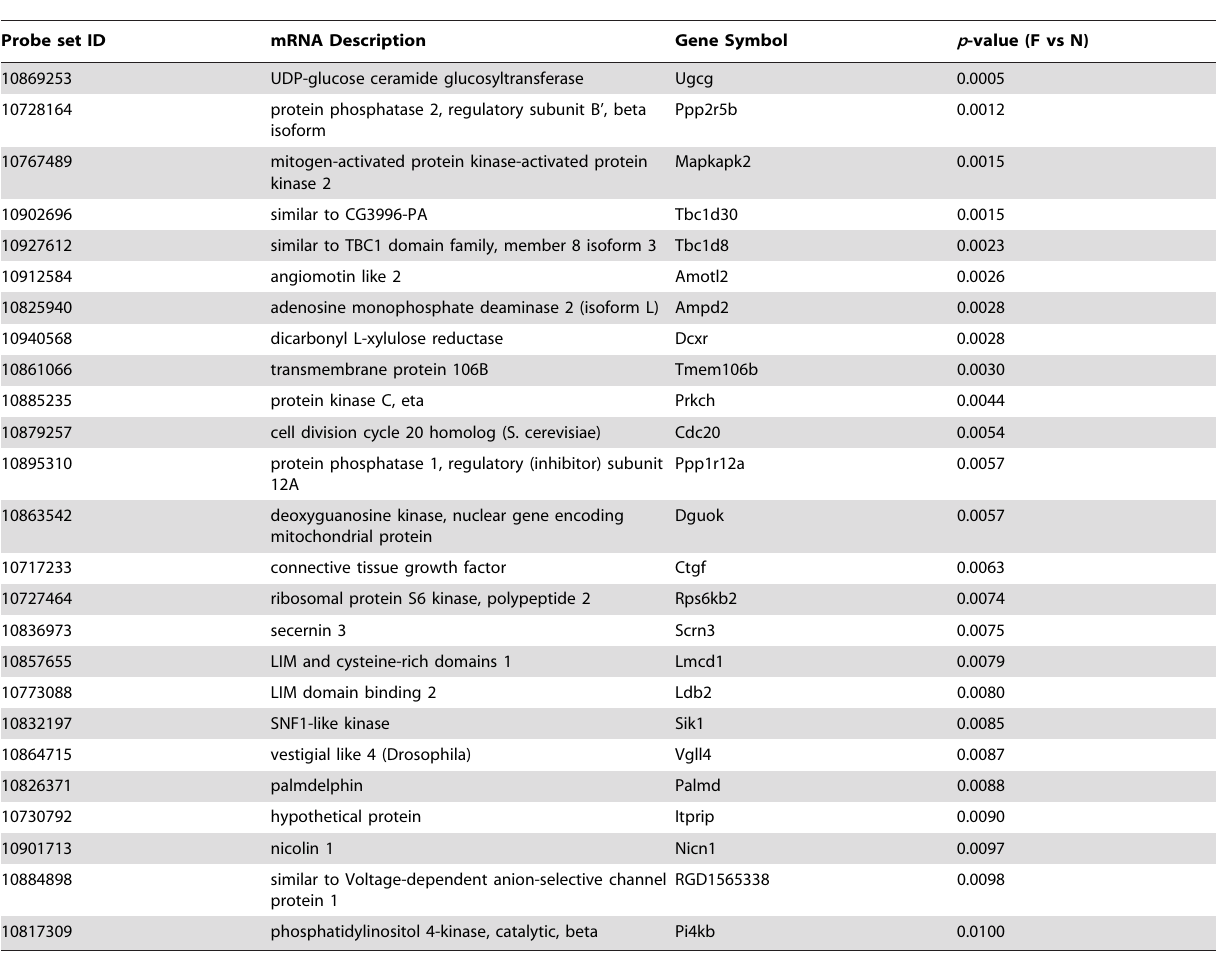
Table 4. Genes showed a significant change ( p , 0.01) between F and N in the DA.